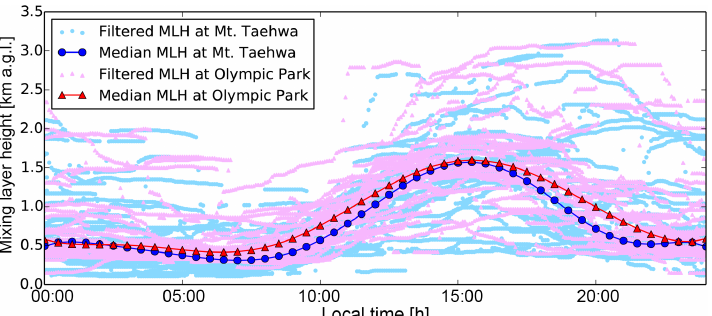
Figure 6. Mixing layer height (MLH) above ground level derived from Vaisala Ceilometer CL51 backscatter profiles (910nm) over Olympic Park and Mt. Taehwa during